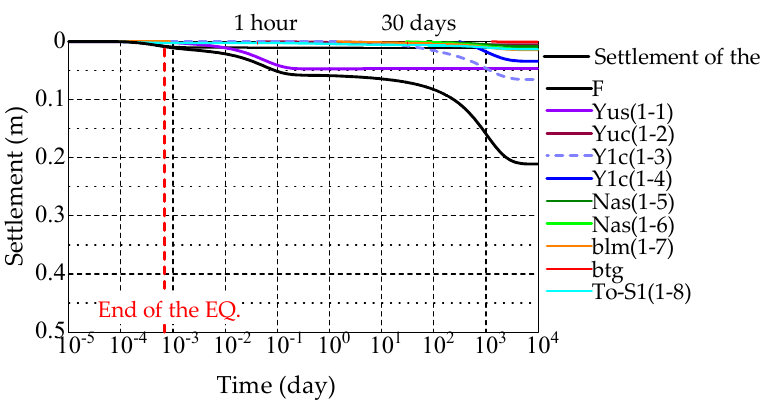
Figure 12. Settlement behavior during and after earthquake: seismic motion (B).